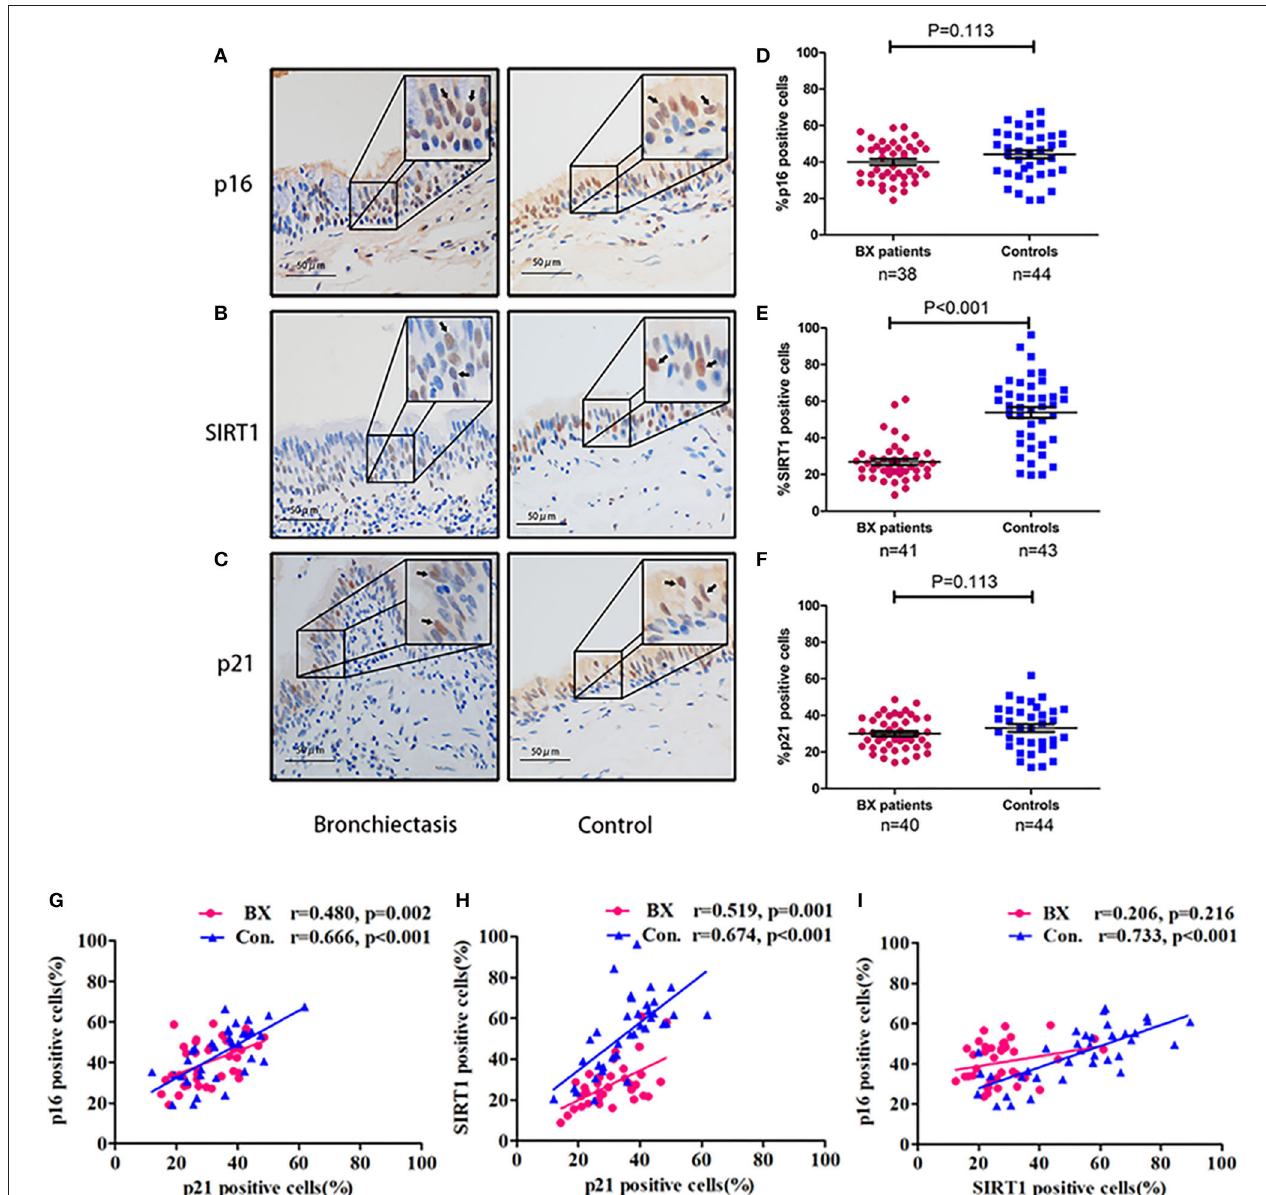
FIGURE 5 | Expression patterns of SIRT1, p16, and p21 within the bronchial epithelium in patients with bronchiectasis and disease controls. (A–C) Representative images showing the expression patterns of p16, SIRT1, and p21 within the bronchial epithelium in patients with bronchiectasis and disease controls scheduled for segmentectomy or lobectomy. (A) Immunohistochemistry staining of p16; (B) Immunohistochemistry staining of SIRT1; and (C) Immunohistochemistry staining of p21. The upper right quadrant of each panel demonstrates a magnified image of the positively stained cells, which are indicated with the arrow heads. Positive staining is defined as the presence of staining of the senescence marker within the cell nuclei. (D–F) Comparison of the percentage of positively stained cells (vertical axis) for p16, SIRT1, and p21. (D) The percentage of cells positively stained with p16; (E) The percentage of cells positively stained with SIRT1; and (F) The percentage of cells positively stained with p21. (G–I) Correlation of the percentage of positively stained cells for p16, SIRT1, and p21; (G) Correlation between p16 and p21; (H) Correlation between SIRT1 and p21; and (I) Correlation between SIRT1 and p16. Bx, bronchiectasis; SIRT1, sirtuin 1; Con, disease